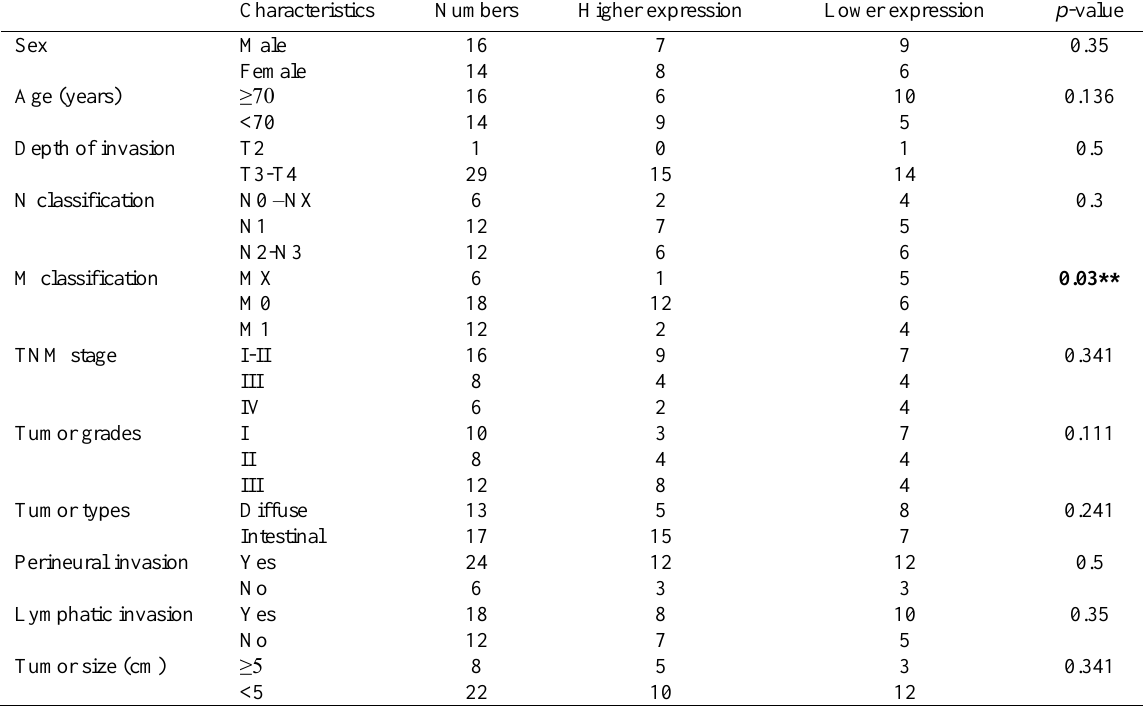
Table 2. Correlation between HNF1A-AS1 expression and clinicopathological parameters of gastric cancer